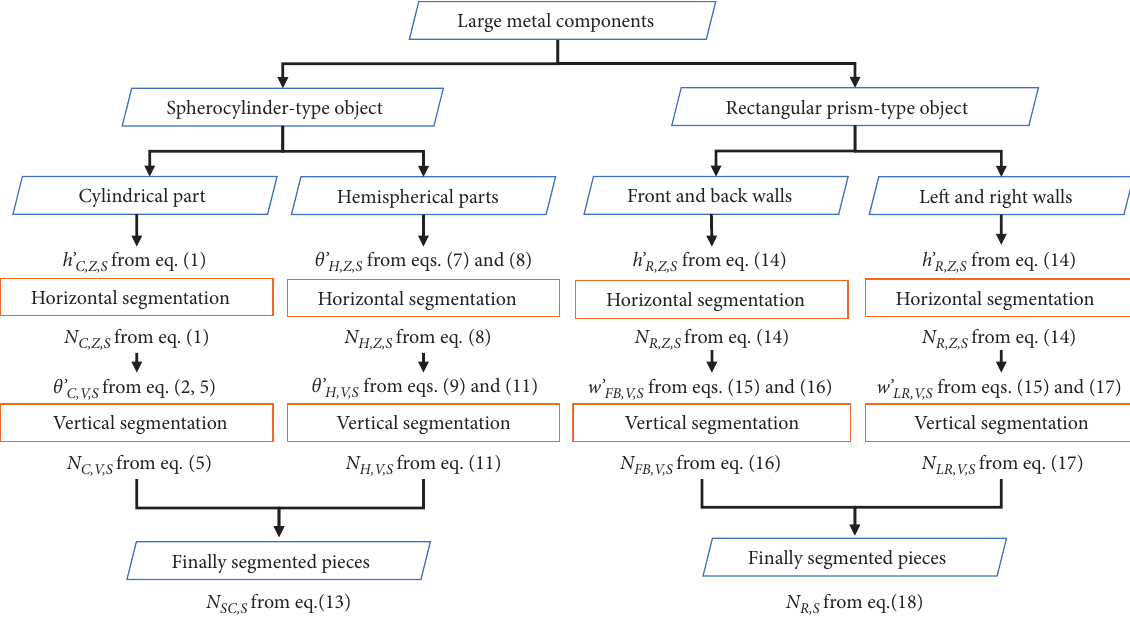
Figure 9: Flow chart of generalized approach to establishing segmentation strategy for large metal components developed in this